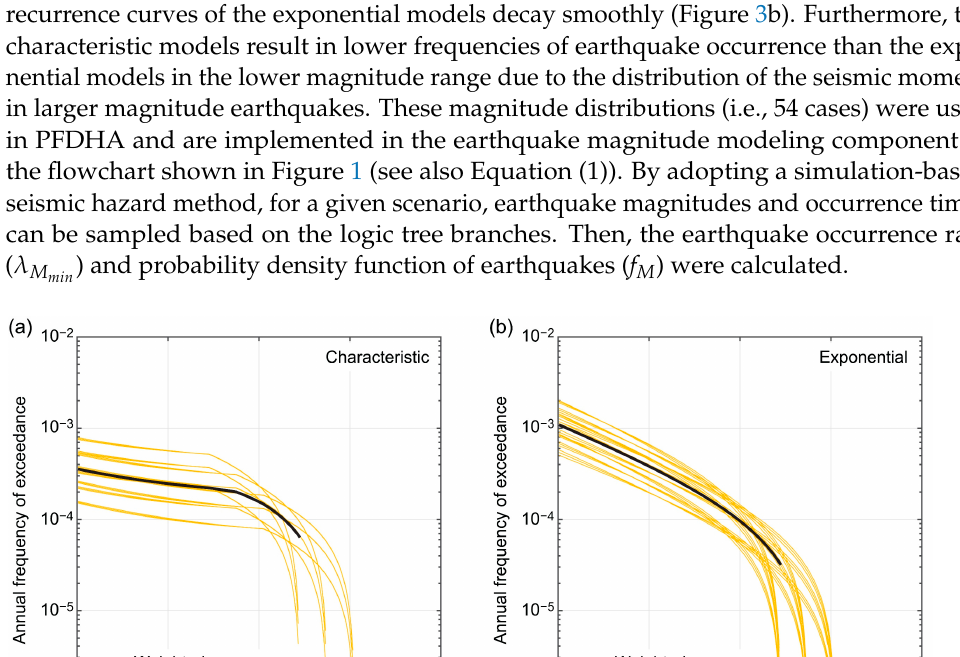
Table 1. Logic-tree parameter values and associated weights of the magnitude model for the Leech River Valley Fault. Parameter values and weights were adopted from [26].